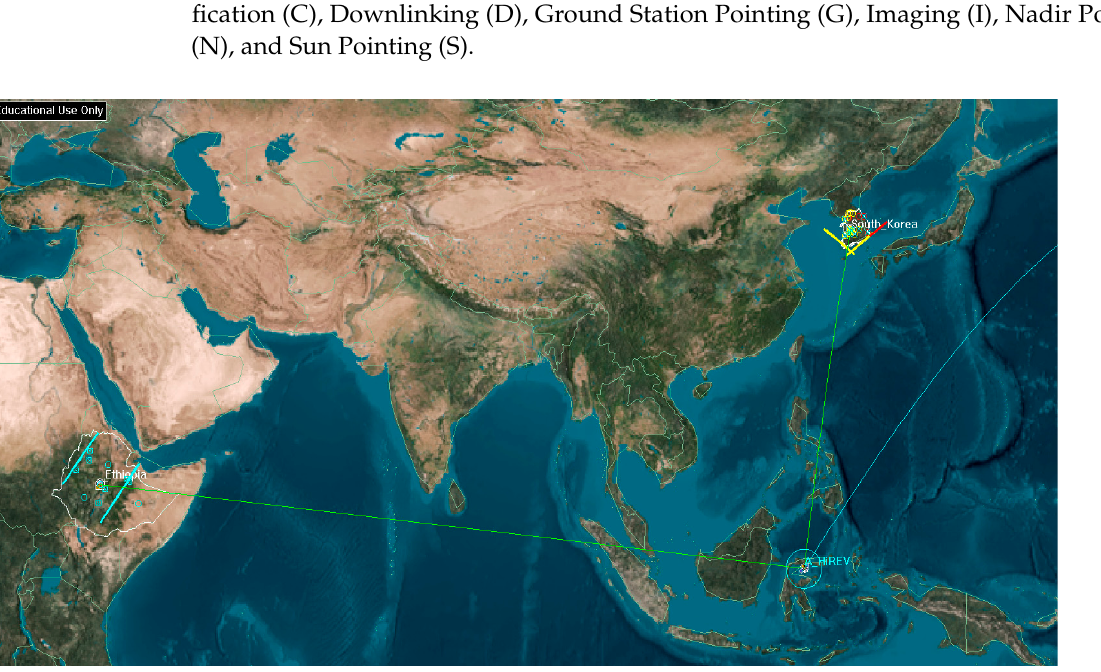
Figure 6. STK Simulation of Target Areas and Ground Stations.